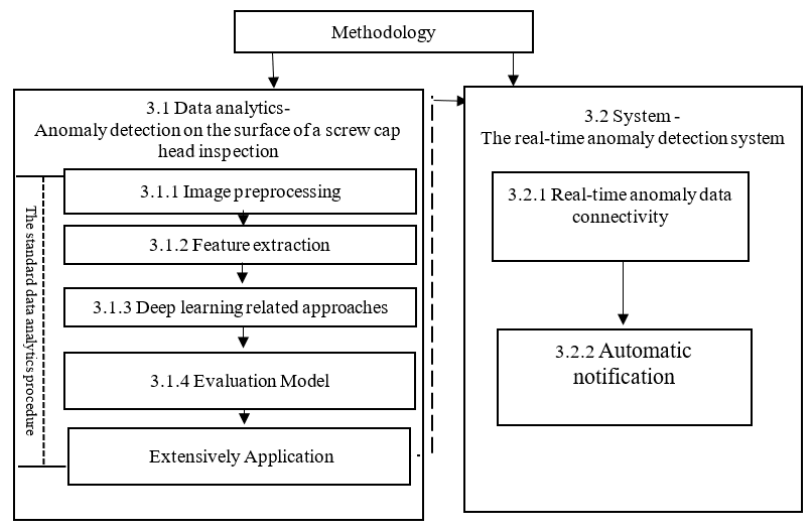
Figure 2. The methodology